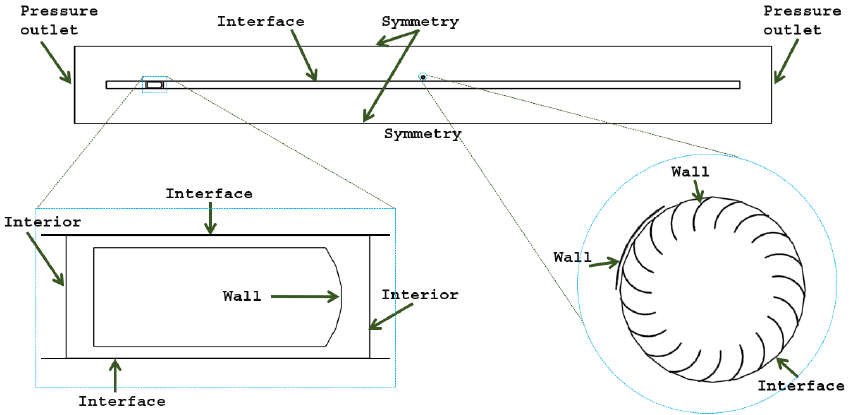
Figure 5. Dimension of cell zones.